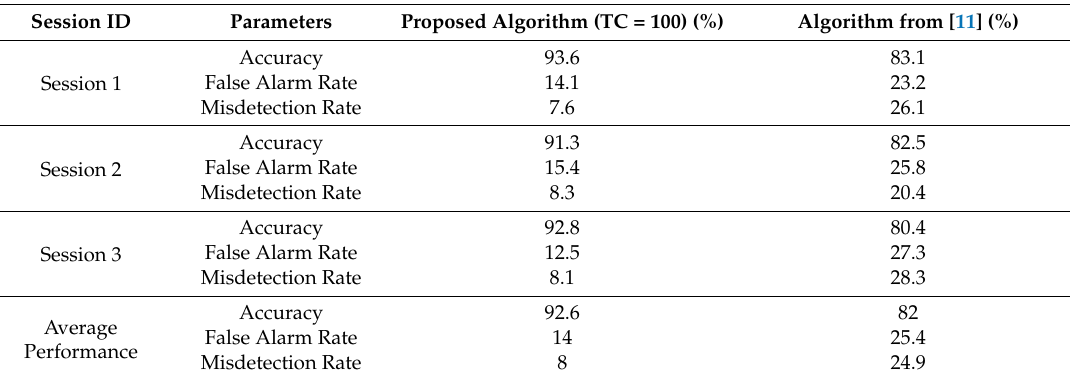
Table 3. Fault detection performance in the defined